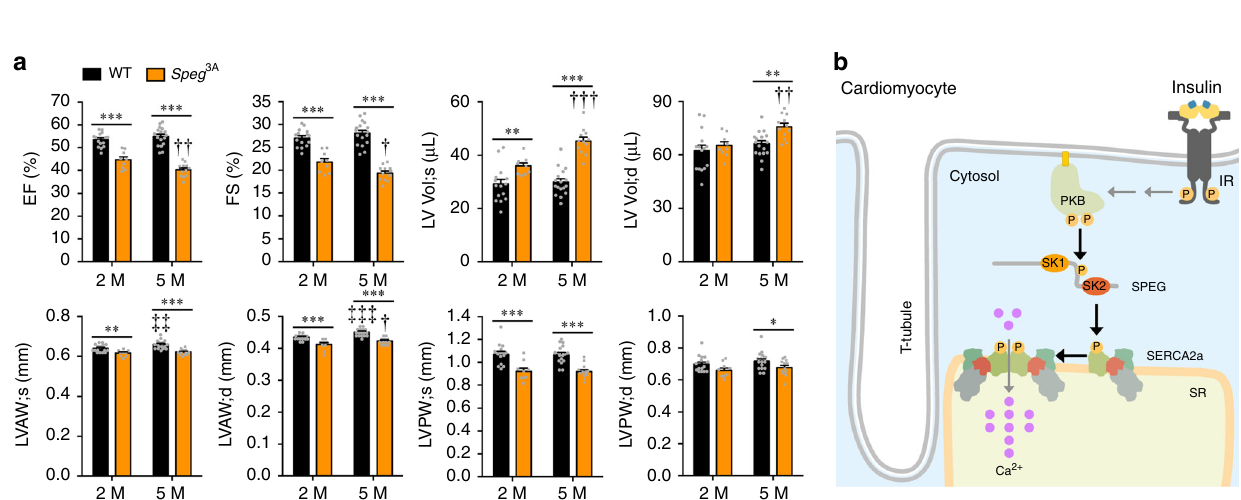
Fig. 9 Cardiac function of the Speg 3A -knockin mice. a Echocardiography was performed on the anaesthetized male Speg 3A -knockin mice and wild-type littermates at age of 2 and 5 months to measure EF, FS, LV Vol;s, LV Vol;d, LVAW;s, LVAW;d, LVPW;s, and LVPW;d. n = 15 (WT, 2 M), 17 (WT, 5 M), 9 (Speg 3A , 2 M), and 12 (Speg 3A , 5 M). The data are given as the mean ± SEM. Statistical analyses were carried out using two-way ANOVA. One-asterisk (WT vs Speg 3A ) and one-dagger ( Speg 3A 2 M vs Speg 3A 5 M) indicate p < 0.05. Two-asterisk (WT vs Speg 3A ), two-dagger ( Speg 3A 2 M vs Speg 3A 5 M), and two-diesis (WT 2 M vs WT 5 M) indicate p < 0.01. Three-asterisk (WT vs Speg 3A ), three-dagger ( Speg 3A 2 M vs Speg 3A 5 M), and three-diesis (WT 2 M vs WT 5 M) indicate p < 0.001. b A diagram represents the proposed model in which the PKB − SPEG signaling nexus links insulin signaling with calcium homeostasis in cardiomyocytes to maintain cardiac function. Upon insulin stimulation, PKB phosphorylates SPEG and activates its second kinase domain, which consequently phosphorylates SERCA2a. Phosphorylation of SERCA2a increases its dimerization that enhances its Ca 2 + -transporting activity. Impaired SPEG phosphorylation by PKB links insulin resistance with cardiac dysfunction through SERCA2a-mediated Ca 2 + reuptake into the SR in cardiomyocytes independent of metabolic assaults. Source data are provided as a Source Data fi